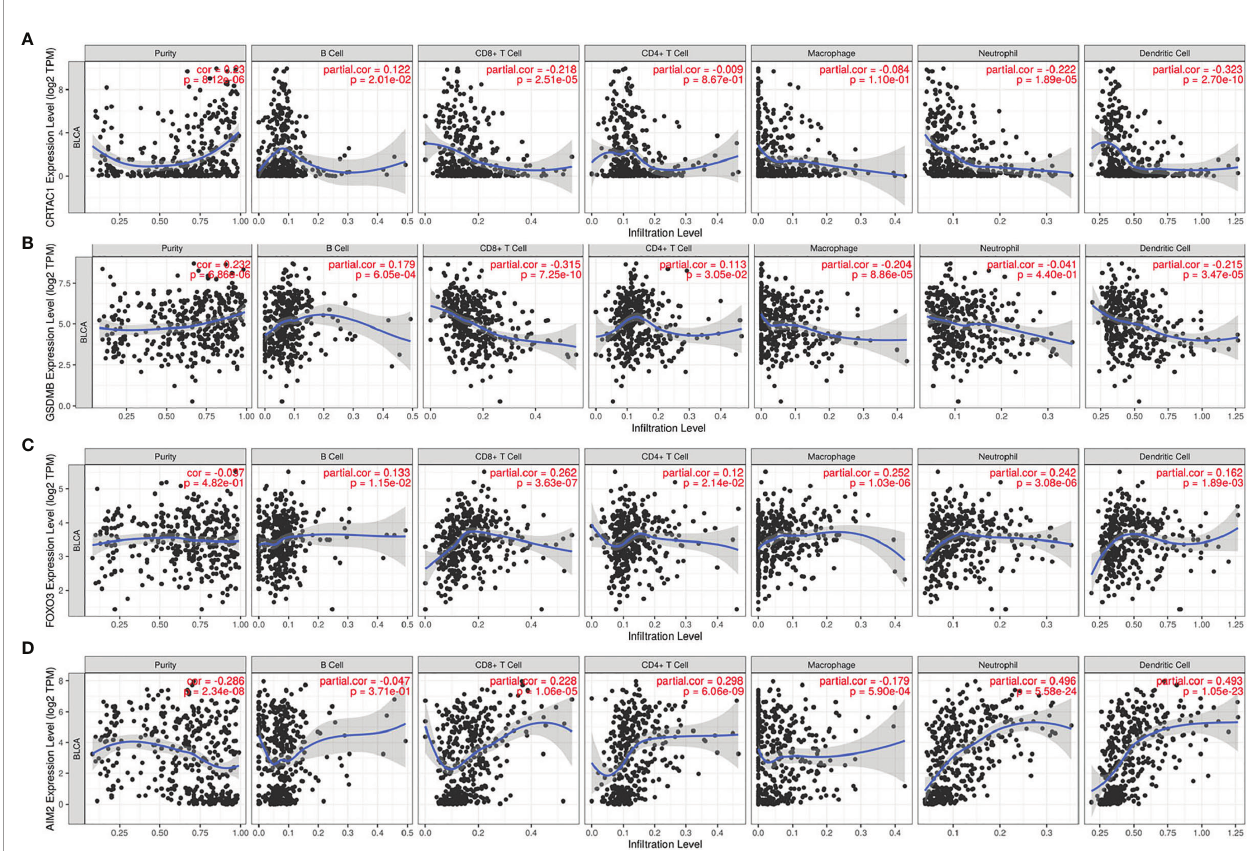
FIGURE 9 | The relevance between pyroptosis-related prognostic genes and immune cell in fi ltration. The correlation between the abundance of immune cells and the expression of (A) CRTAC1, (B) GSDMB, (C) FOXO3, (D) AIM2 in